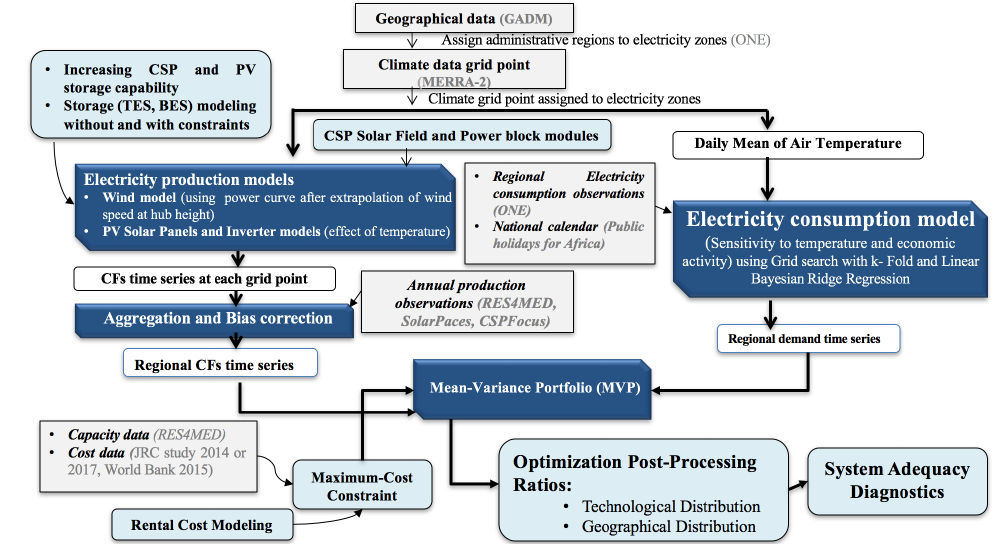
Figure 1. Flow chart of E4CLIM components (dark blue) including the modules added (light blue) and the data sources (gray) illustrating the general framework of this study. TheE4CLIM’s flow is divided in three steps: (1) Capacity factors and demand time series are first estimated from climate grid points and fitted to observations; (2) The mix is then optimized using the Mean-Variance Portfolio (MVP) approach; (3) The mix properties (technological and geographical distribution) are analysed; (4) The load-bands reduction diagnostics based on the “Residual Load Duration Curve (RLDC)” are finally computed to give a more detailed analysis of the services provided by different RE